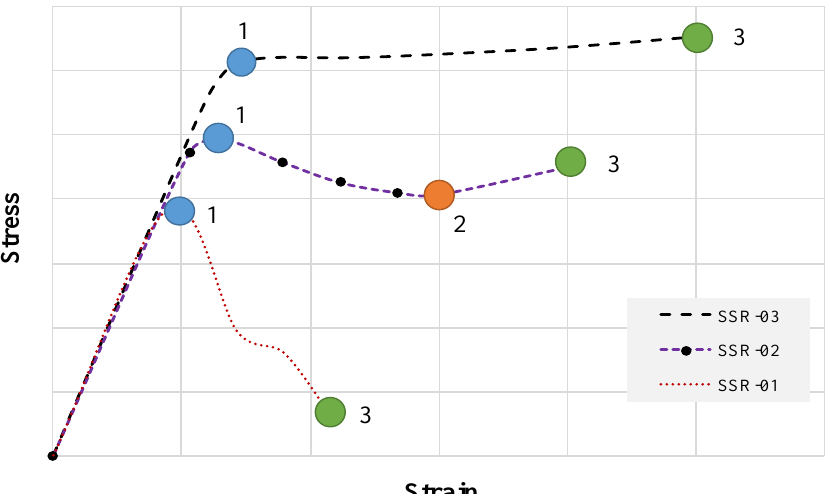
Figure 13. Types of stress–strain response (SSR) observed.